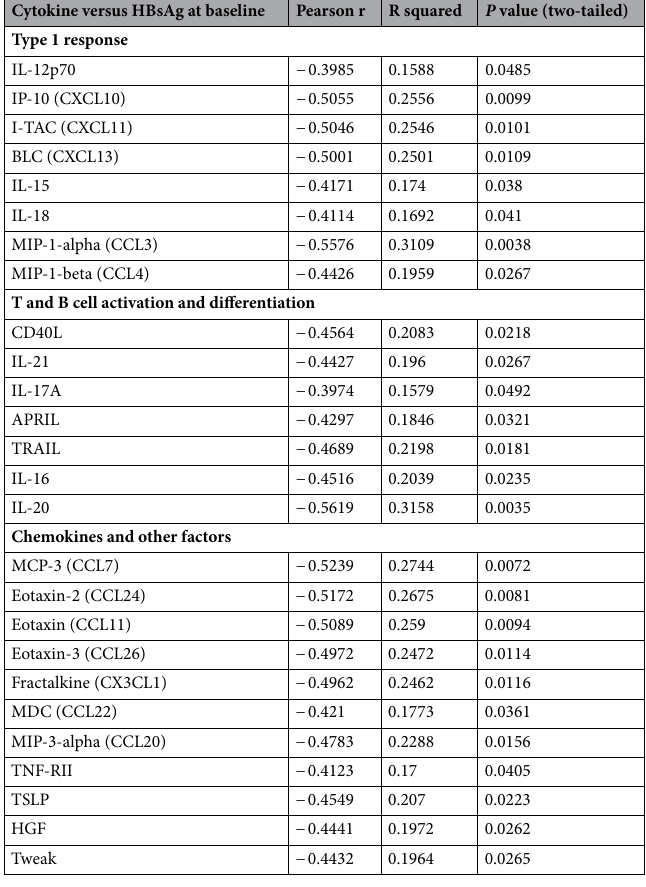
Table 1. Pearson correlation analysis of cytokines to HBsAg levels at baseline (T0) time-point. Pearson correlation coefficient (r) and R square of cytokines to levels of HBsAg at baseline time-point (T0). Only cytokines with a two-tailed P value less than 0.05 are